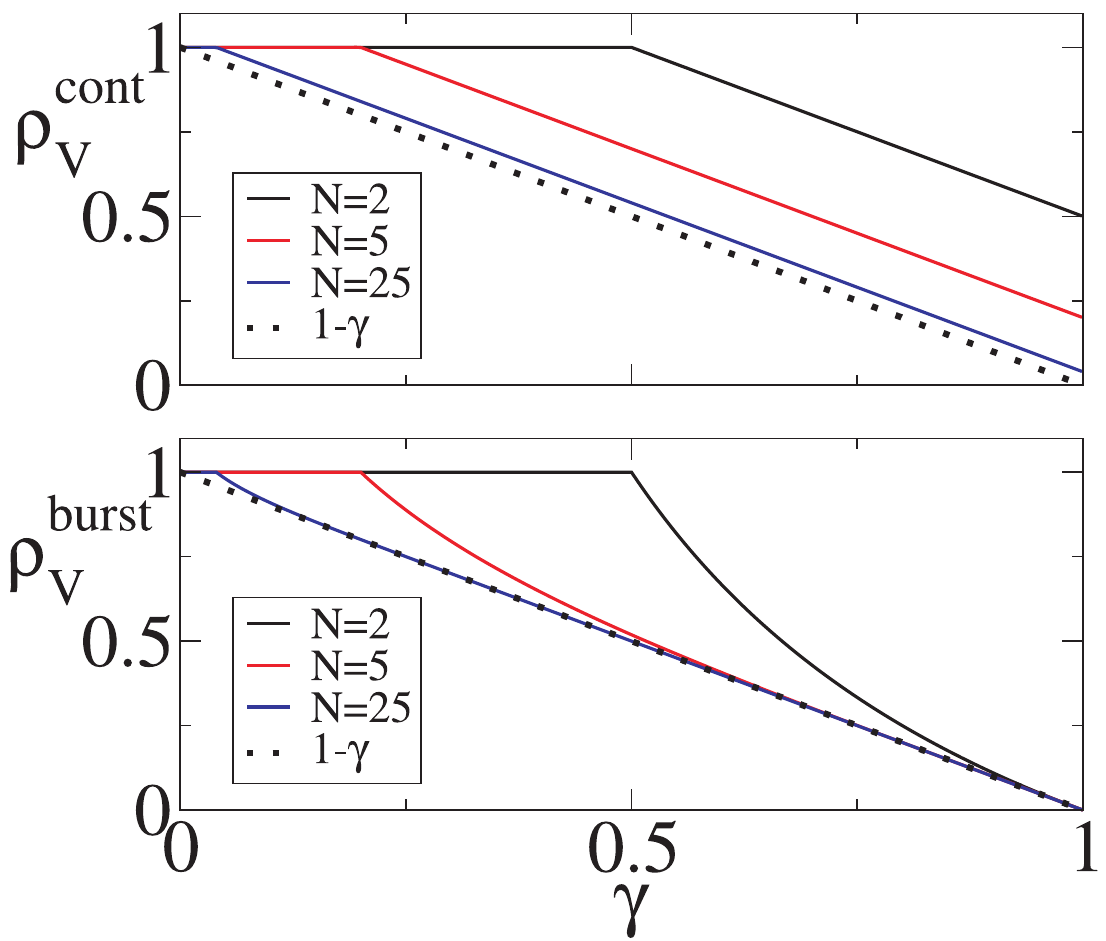
Figure 2. The single virion extinction probability, r V , versus c , the probability that a virion infects a cell rather than is cleared. Dashed lines: burst model. Solid lines: continuous production model. Black dashed (solid) lines: N ~ 2 burst (continuous). Red dashed (solid) lines: N ~ 5 burst (continuous). Blue dashed (solid) lines: N ~ 25 burst (continuous). The heavy dotted line is the limiting curve r V ~ 1 { c .